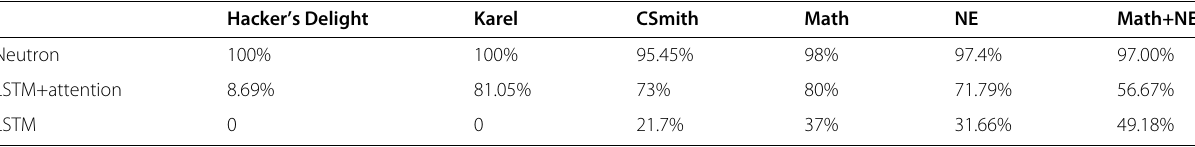
Table 1 Performance on different